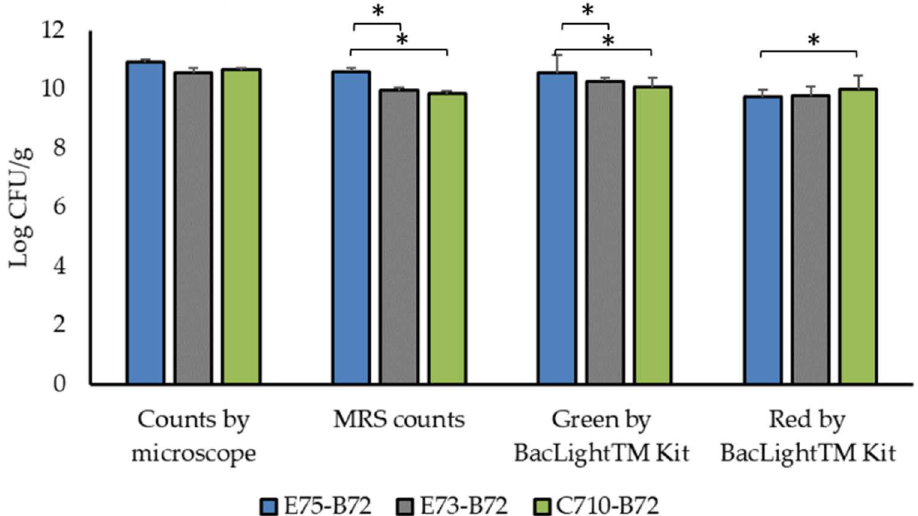
Figure 2. Microbial viability (Log CFU/g) after wet granulation. MRS counts were done in triplicate and counts at the microscope were repeated five times. Results are reported as mean values ± SD. Asterisks indicate significant differences among strains’ combinations ( p <